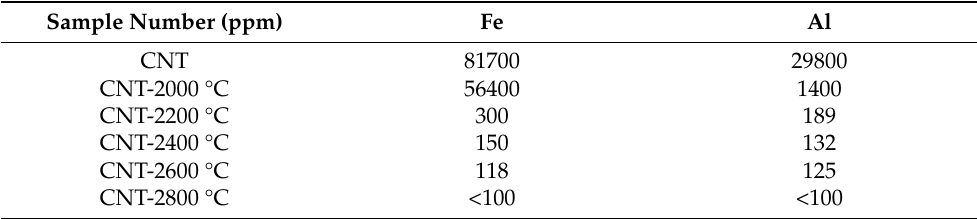
Table 1. Impurity content of MWNTs annealed at different temperatures for 180 min by